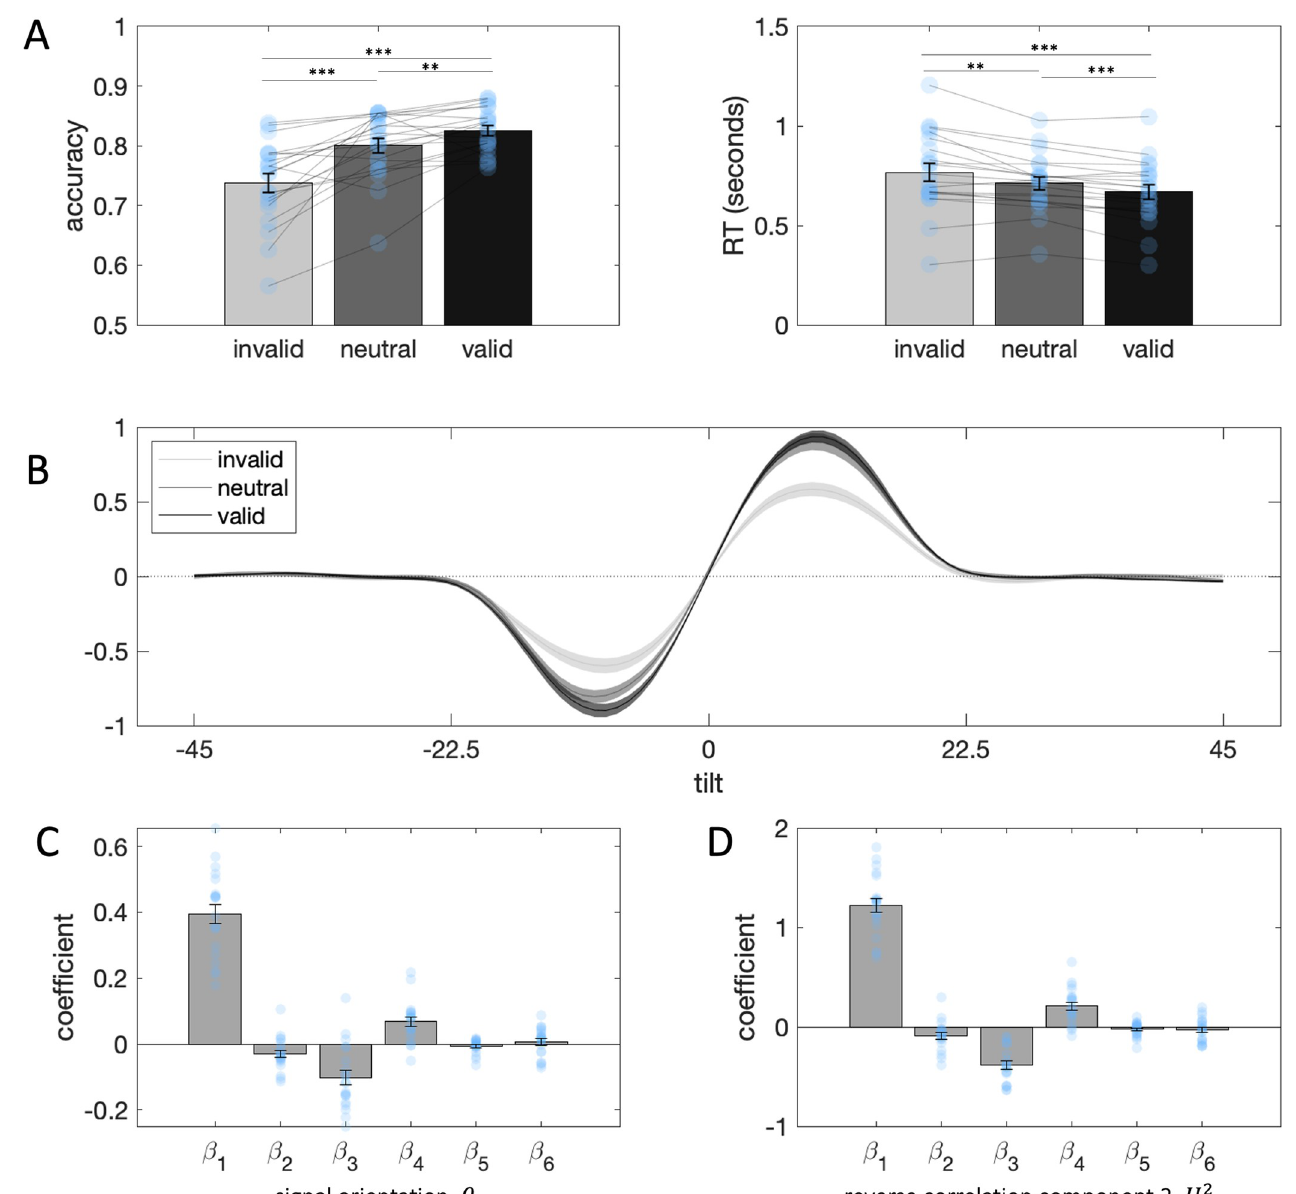
Fig 4. A. Manipulation checks. Left : Accuracy across invalid, neutral and valid trials. Right : Response times across invalid, neutral and valid trials; statistical tests were performed on log transformed measures. Stars denote statistical significance: �� : p < 0.05, ��� : p < 0.001. B. Decision kernels for invalid, neutral and valid trials. C. Beta coefficients from binomial regression on signal orientation. Grey bars denote averages, error bars denote standard error of the mean, blue circles denote individual participants. β 1 is the coefficient for the target stimulus, β 2 − the distracter, β 3 − the interaction between target and the consistency between target and distracter, β 4 − the interaction between target and cueing condition (coded as -1 = invalid, 0 = neutral, 1 = valid), β 5 − the interaction between the distracter and cueing condition, β 6 − the three-way interaction between target, target-distracter consistency and cueing condition. D. As in C, but dependent variables in the regression correspond to the score for SVD component 2 from the reverse correlation analysis.